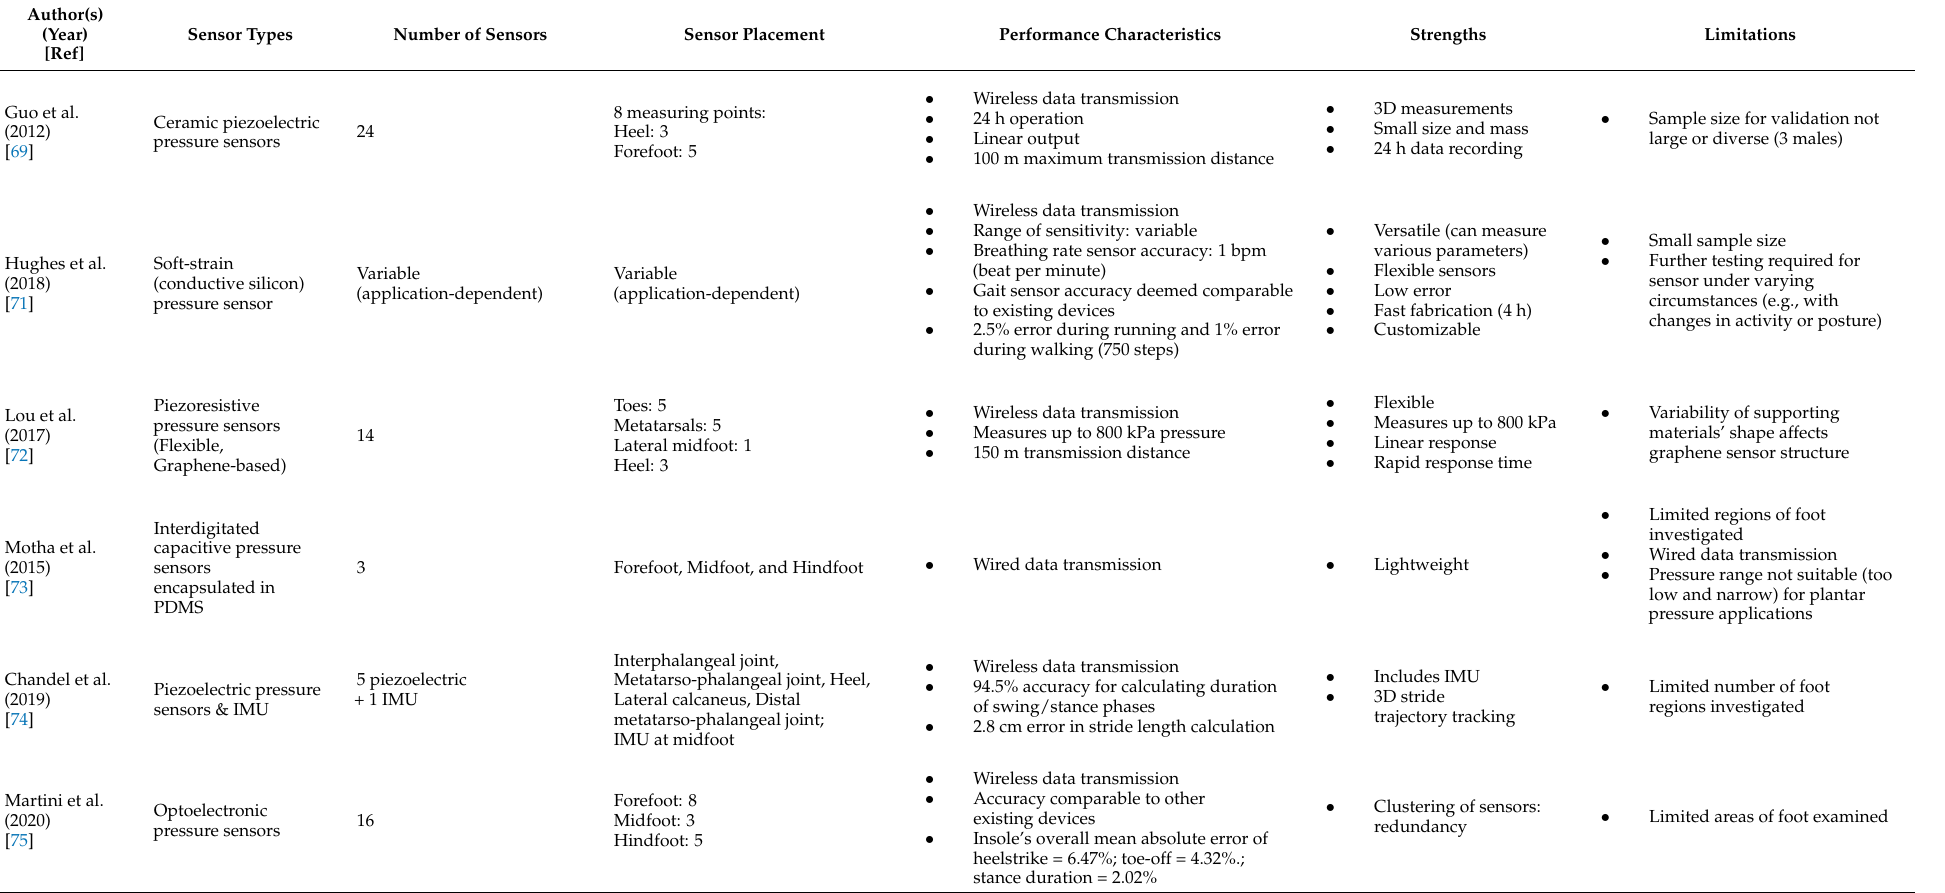
Table 1. Key points pertaining to various existing insole-based sensor systems used for plantar pressure measurements and gait